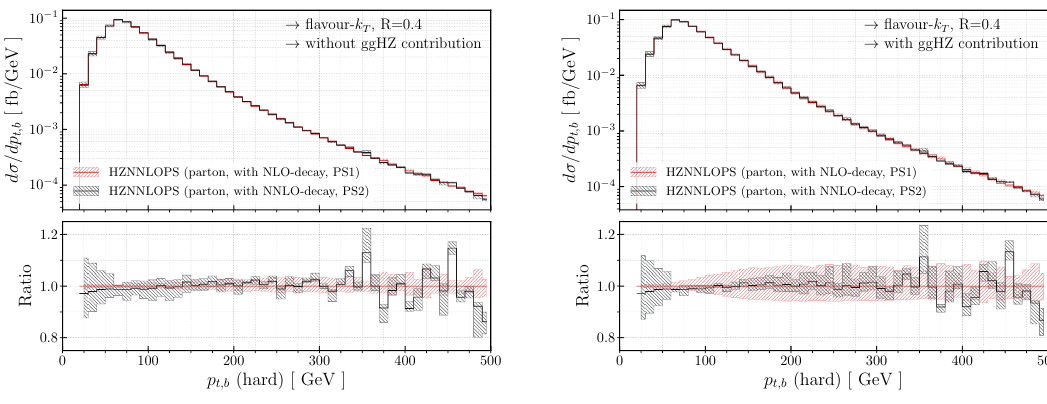
Figure 4 . As (cid:12)gure 2 but for the hardest of the two b -jets used for the Higgs reconstruction, p t;b (hard), without (left) and with (right) the gluon-induced terms, and without the cut on p t;Z . is slightly narrower. This is expected since, for the new result, NNLO corrections in the decay are